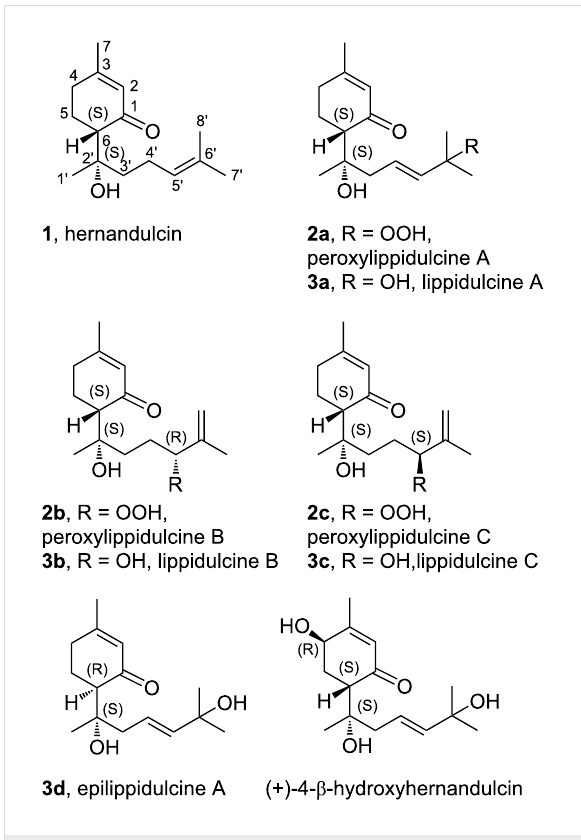
Figure 1: Hernandulcin and other bisabolanic derivatives extracted from Lippia dulcis .